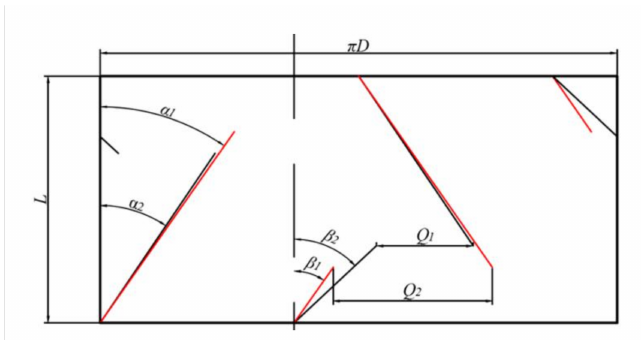
Figure 6. Comparison of internal mixer rotor expansion before and after optimization (diagram).